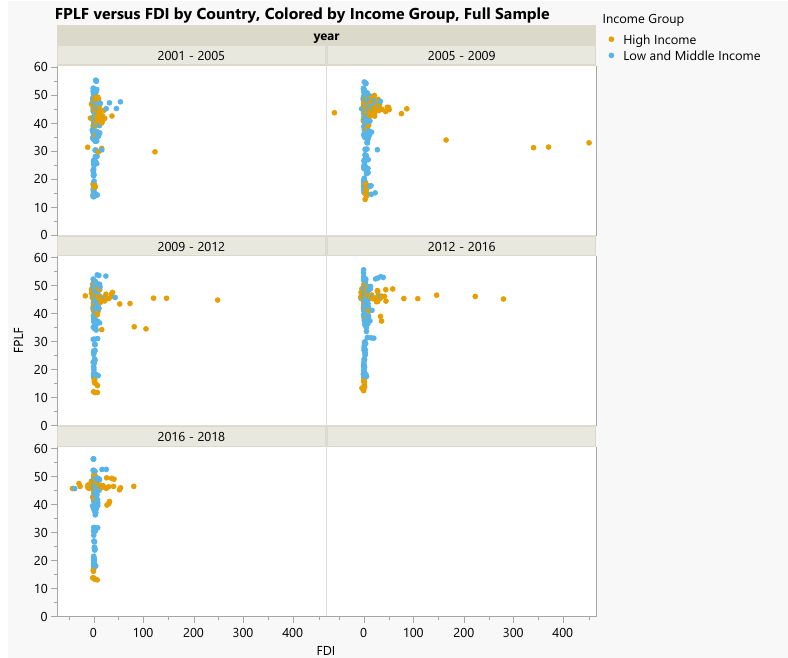
Figure 1. Scatterplots of FPLF versus FDI with observations grouped in panels of 5 years and colored by income group, all countries included. The extreme outliers in the direction of FDI are observations from Malta and Cyprus. The fact that these observations are extreme outliers in the direction of the main explanatory factor, FDI, makes them prime suspects for having strong influence on the model estimation results as far as the effect of FDI. Source: authors’ calculation. FPLF versus FDI by Country, Colored by Income Group, with Malta and Cyprus Excluded from the Sample year